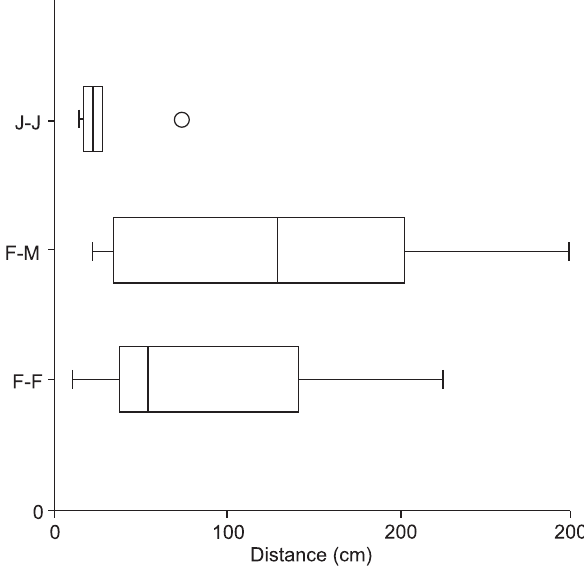
Figure 2. The distance between juveniles to juveniles (J-J), females to males (F-M) and female to female (F-F) conspecifcs of Charinus asturius . See text for more details. Vertical bars correspond to the median, whiskers indicate 1.5 times the interquartile range of the data (right or left the first and third quartiles), The point is an